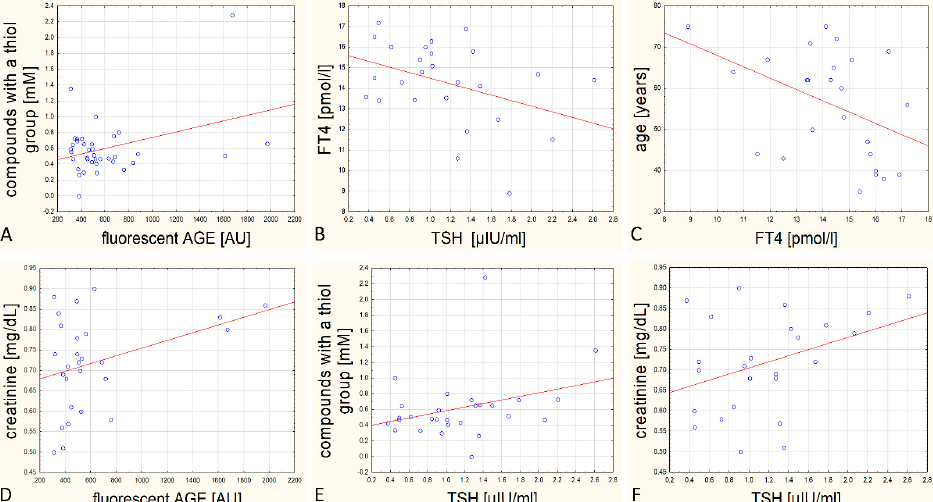
Figure 5. Graphs of dispersion of results for pairs of analysed parameters in blood serum. Panel ( A )—dependency between the content of compounds with thiol groups and fluorescent AGEs, panel ( B )—dependency between concentration of FT4 and TSH, panel ( C )—dependency between patient’s age and FT4 concentration, panel ( D )—dependency between creatinine level and amount of fluorescent AGE products in serum, panel ( E )—dependency between compounds with thiol group and TSH, panel ( F )—dependency between concentration of creatinine and TSH. For data from panels ( A – C ) we proved statistically relevant correlation.